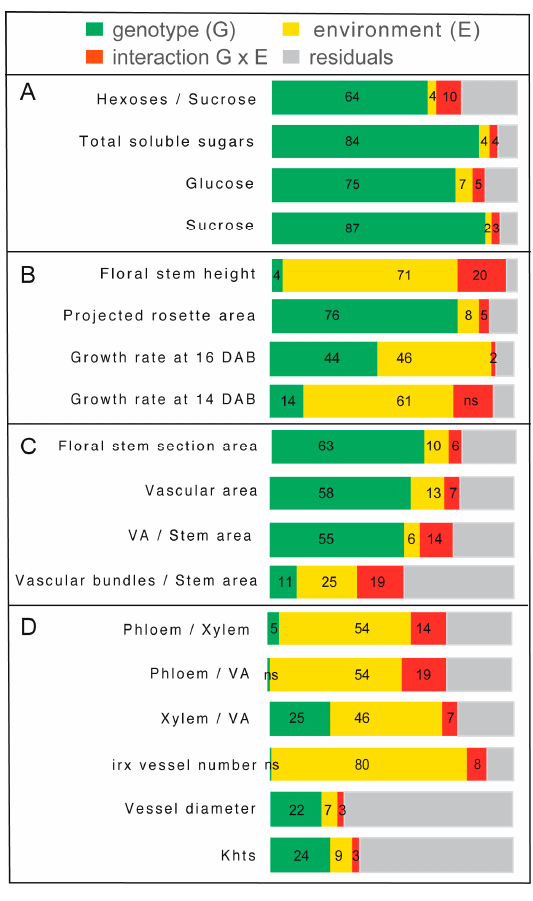
Figure 10. Analysis of variance of the traits measured during the reproductive stage, showing the effects associated with the genotype (G), the environment (E), and the interaction of genotype x environment (GxE) within the overall variations. VA—total vascular area per stem section. irx—number of irregular xylem cells per xylem section. Khts—theoretical hydraulic specific conductivity. For more details on